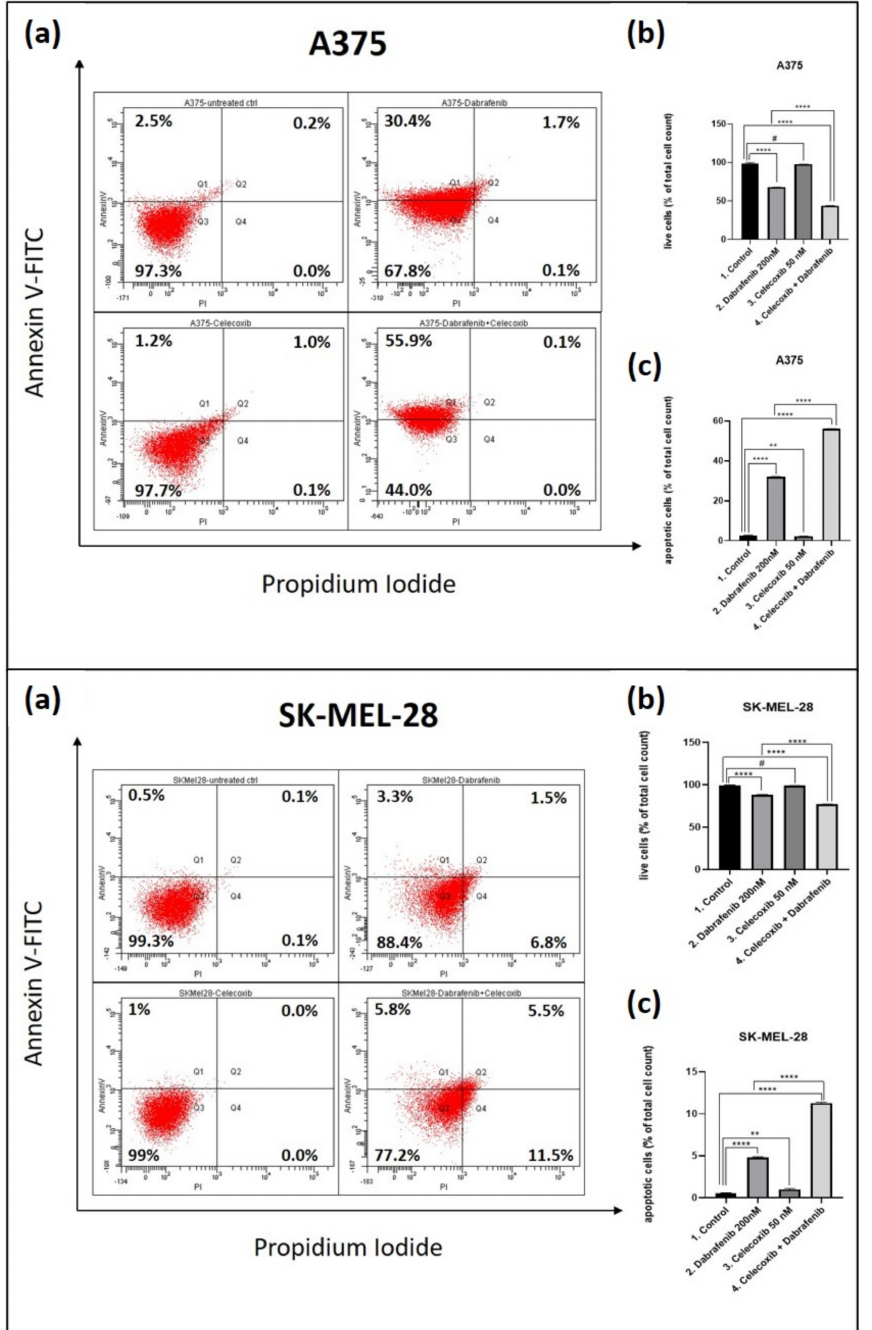
Figure 2. FACS cell death assessment. Comparative FACS analysis following celecoxib and dabrafenib combination was carried in A375 ( upper panel ) and SK-MEL-28 ( lower panel ) human melanoma cell lines. Quantitative FACS results in each case are illustrated as % of total cell count of annexin V- and PI-positive cells, compared to total cell count ( a ). Viable cells ( b ) and Q1 + Q2 apoptotic cells ( c ) were statistically analyzed using GraphPad Software, Ordinary One-way ANOVA test, Multiple comparisons. There was no statistical difference between the viable untreated cells and those treated with celecoxib, although celecoxib induced a slight apoptotic effect. However, celecoxib added to dabrafenib enhanced apoptosis-mediated cell death in the last group compared to control and dabrafenib group. # = p > 0.05 (not significant), ** p < 0.01, **** p < 0.0001 vs. control, untreated cells and **** p < 0.0001 vs. dabrafenib group. Each bar represents mean values ± standard deviation (SD), n =